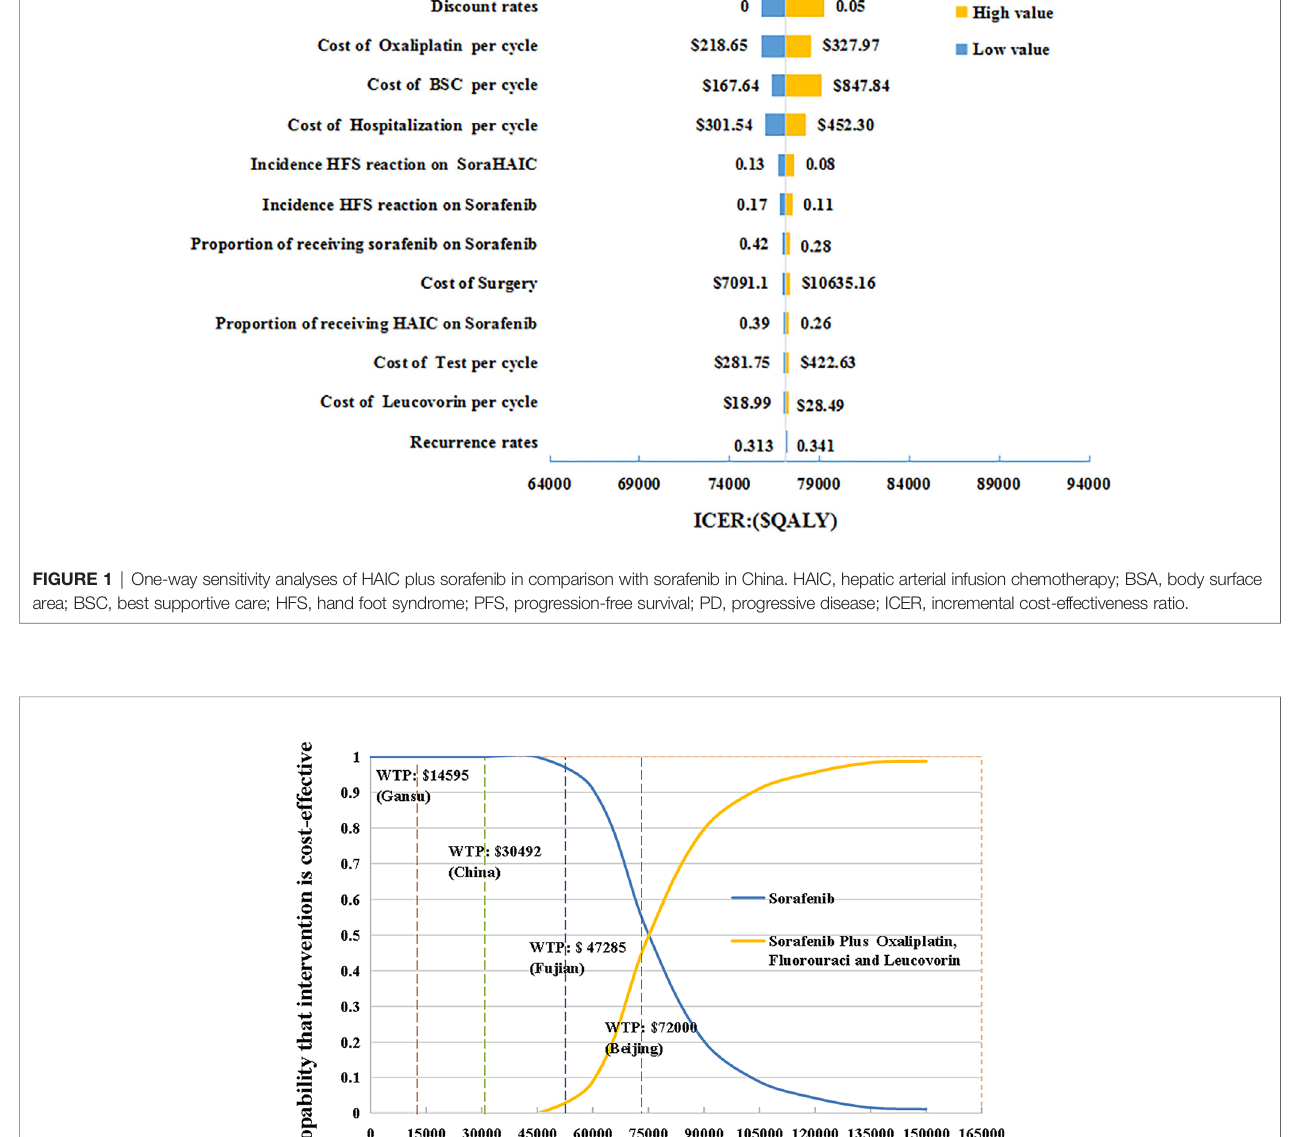
Frontiers in Oncology |